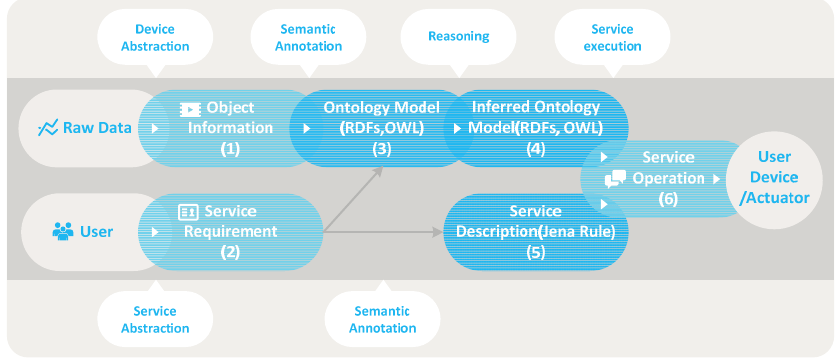
Figure 3. Procedures for the ontology-based context-information